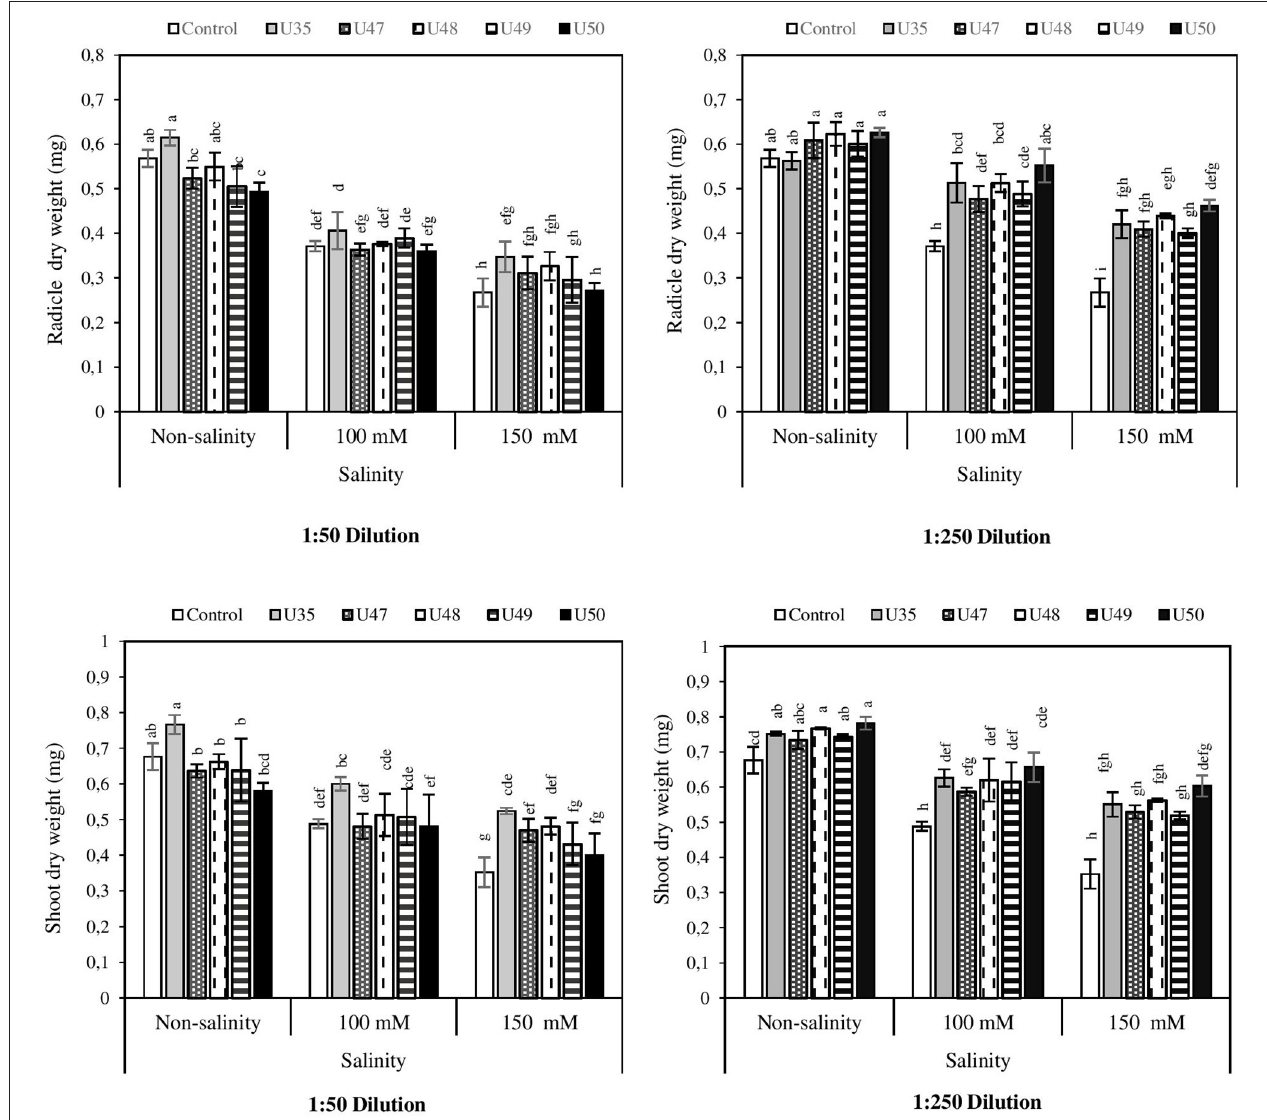
FIGURE 3 | Effect of 1:50 and 1:250 dilutions of Bacillus strain CFSs (U35, 47, 48, 49, and 50) and salinity on radicle and shoot dry weight in corn. Values represent the mean of five replicates ± SD. 1:50 = 1mL Bacillus strain CFSs and 50mL distilled water and 1:250 = 1mL Bacillus strain CFSs and 250mL distilled water.